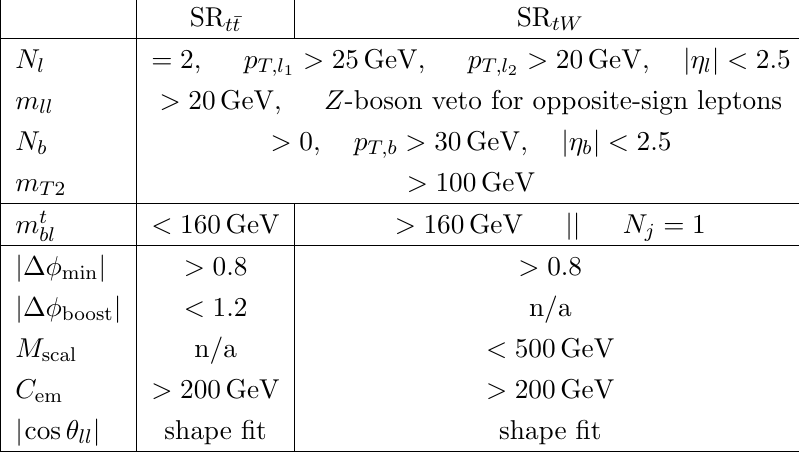
and SR tW . For further details consult the text. t (cid:22) t